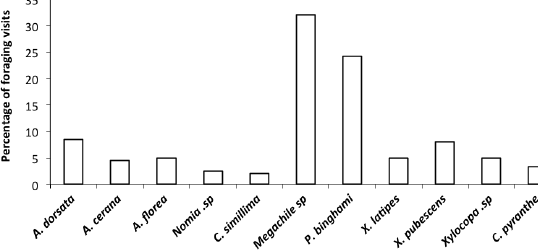
Figure 3. Percentage of foraging visits of insects on Derris